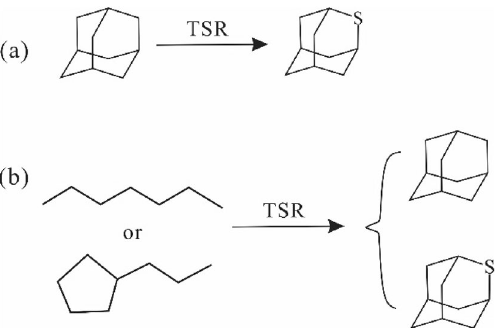
Figure 11. Possible pathways for the formation of diamondoids and thiadiamondoids from the TSR experiments. ( a ) Thiadiamondoids generated from diamondoids 37,38 ; (b) thiadiamondoids generated from non- cage hydrocarbons.